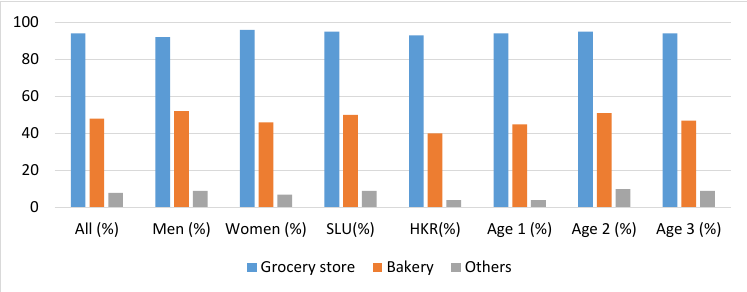
Figure 5. Future willingness to purchase heritage cereal products. T he category “others” includes drinks, smoothies, beer brewing, alcoholic beverages and everything today that is done by modern cereals.